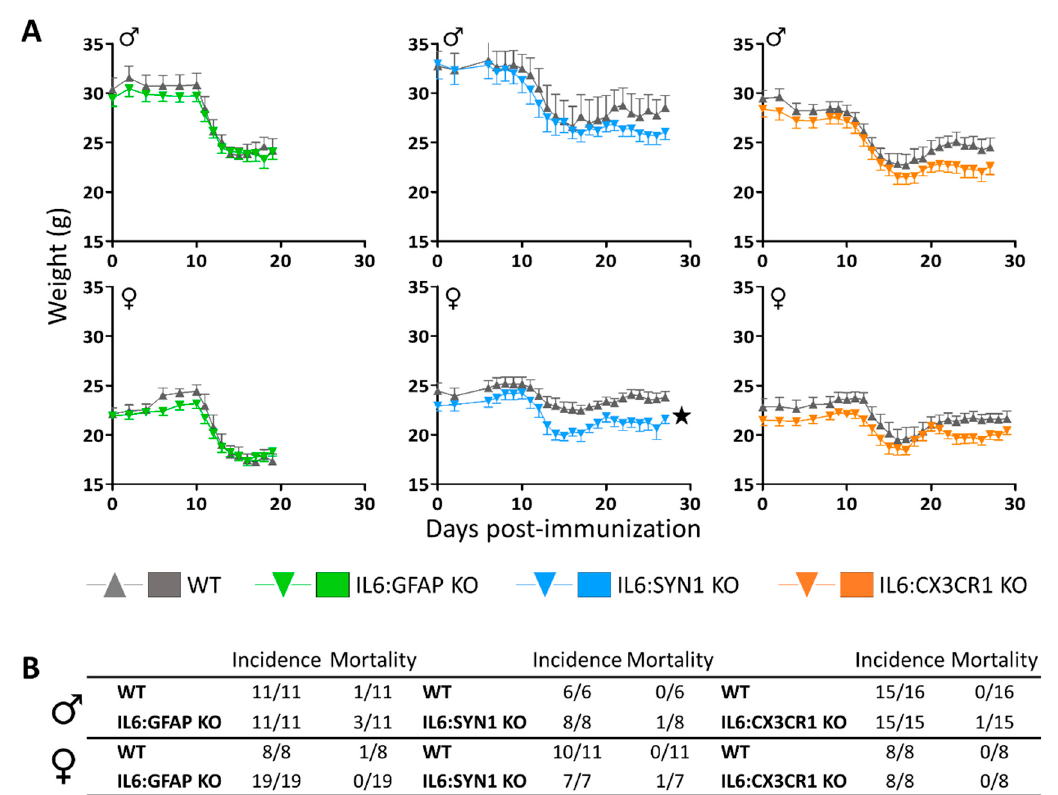
Figure 2. Clinical assessment of EAE. ( A ) Absolute body weight changes of IL6:GFAP KO and WT mice ( left ); IL6:SYN1 KO and WT mice ( middle ); IL6:CX3CR1 KO and WT mice ( right ). All MOG 35-55 -immunized mice displayed a prominent body weight loss peaking approximately at 15–17 dpi. IL6:SYN1 KO females weighed less than their controls regardless of EAE. ( B ) EAE incidence and mortality. Although all mice displayed paralyzing symptoms, the mortality rate was low during the studied days. Number of mice per group as indicated. Results are MEAN ± SEM; ★ p ≤ 0.05 versus WT mice.